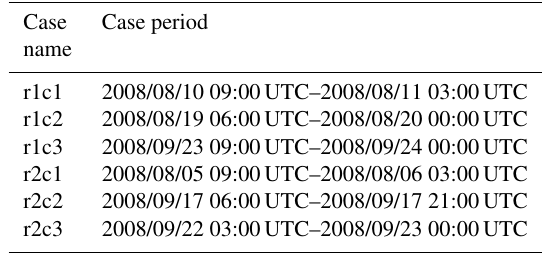
Table 1. The case period of the selected cases in the Sumatra region (r1) and the Borneo region (r2).